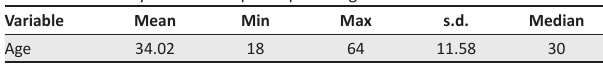
TABLE 1: Summary statistics of participants’